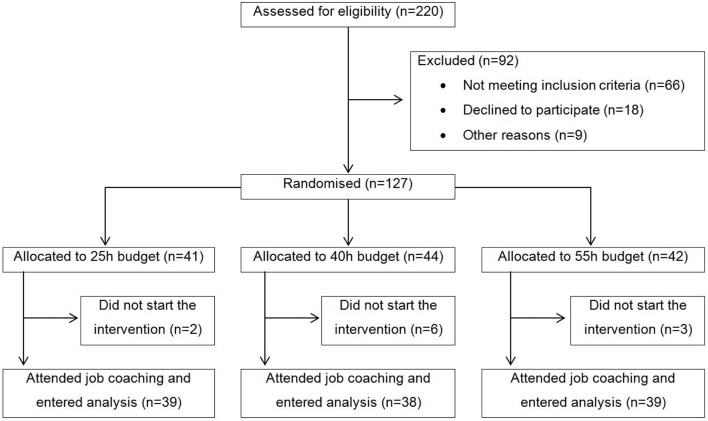
Participant flow.